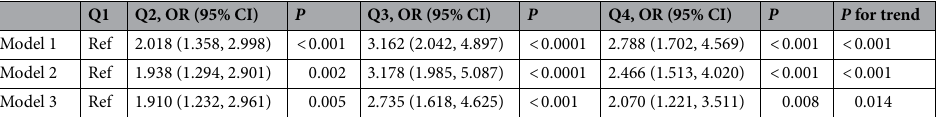
Table 4. Adjusted multinomial logistic regression of VAI with periodontitis in 40–50-year-old population. Model 1: Unadjusted. Model 2: Adjusted for sex. Model 3: Adjusted for sex, ethnicity, education, and